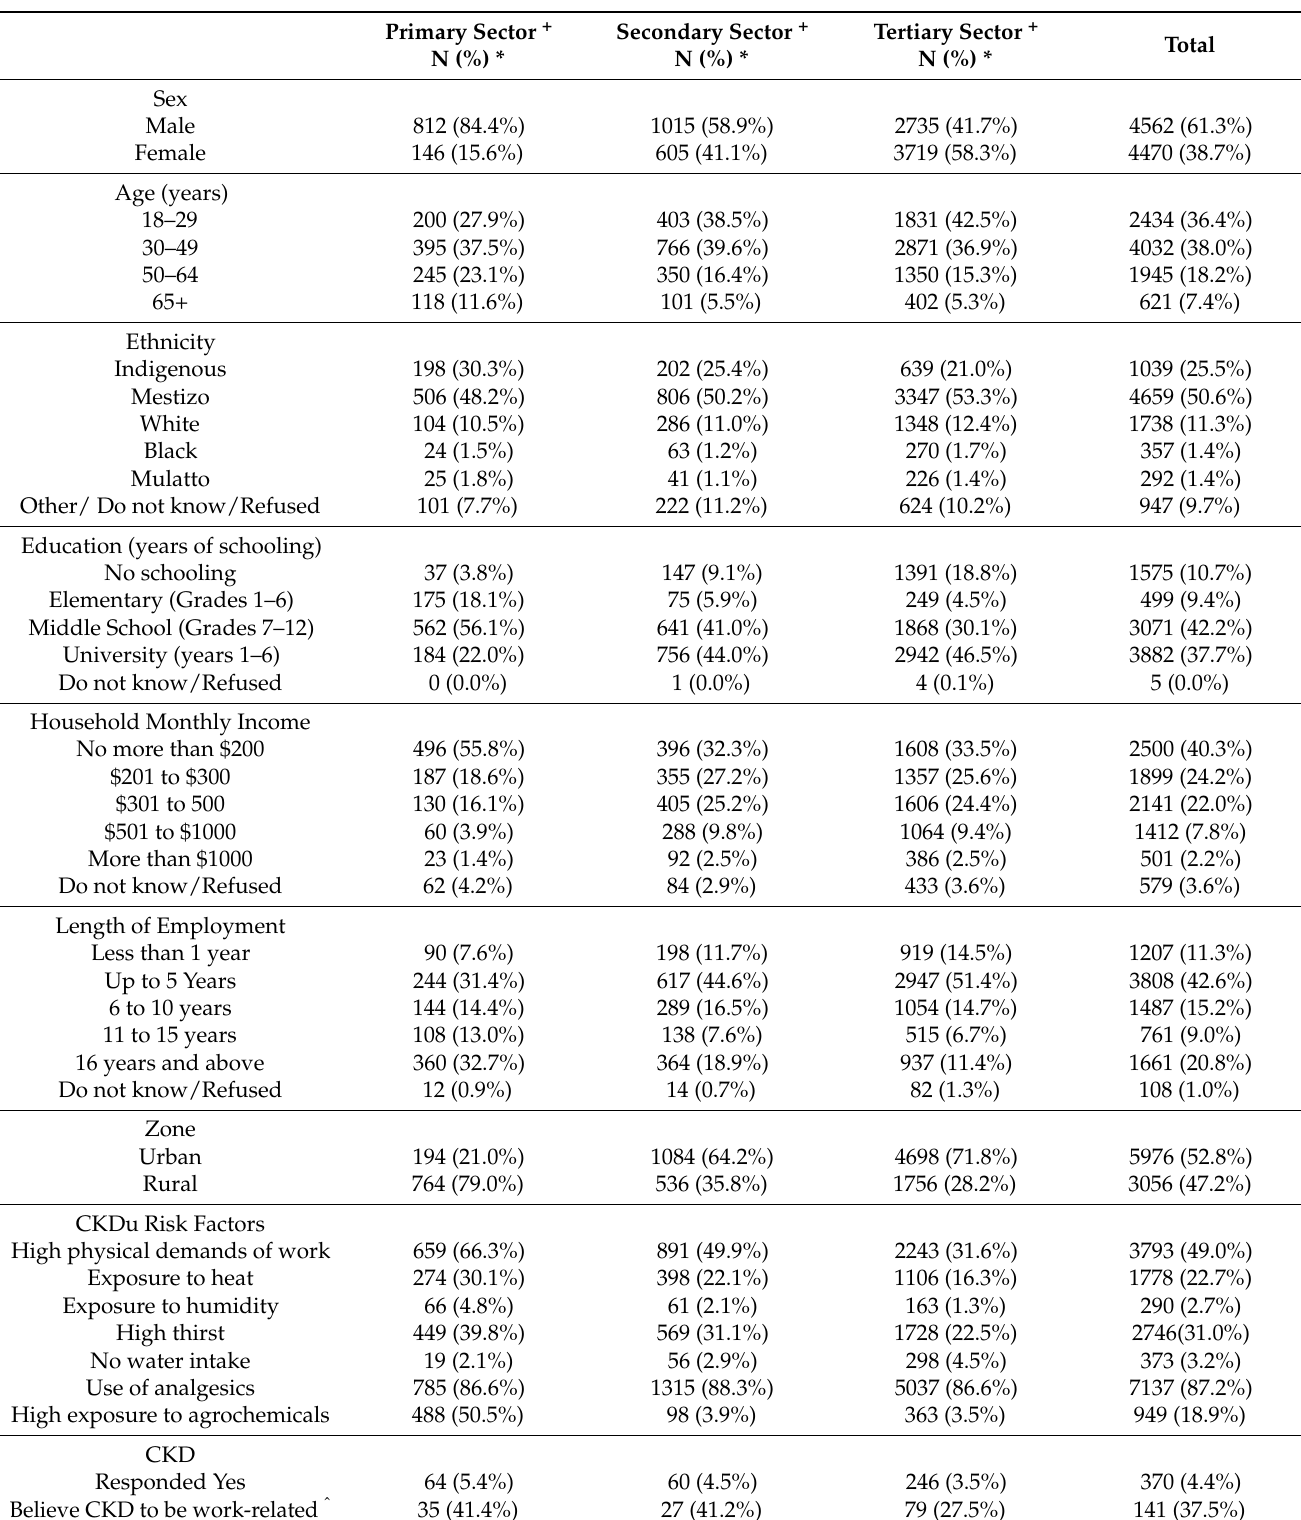
Table 1. Demographics of participants in II ECCTS ( n = 9032) for Central